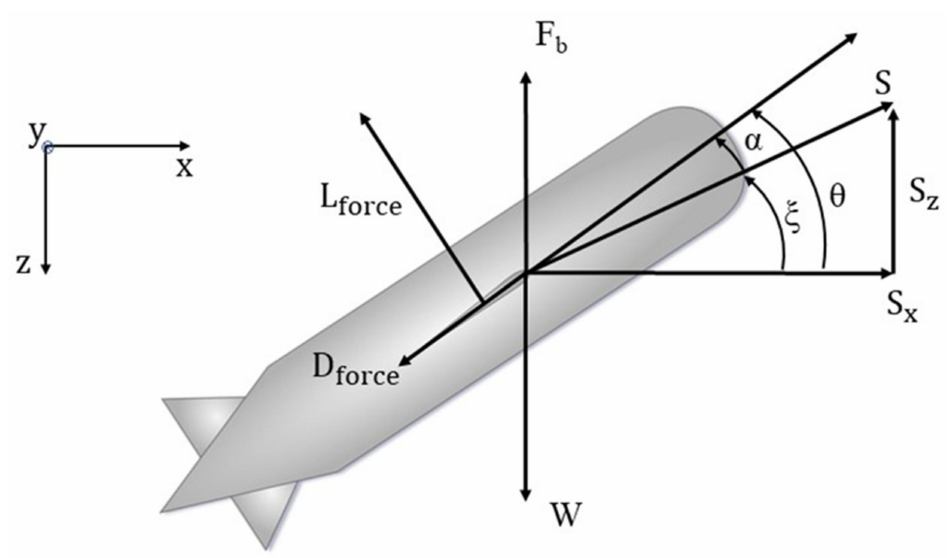
Figure 5. Global parameters of the SFG [14].